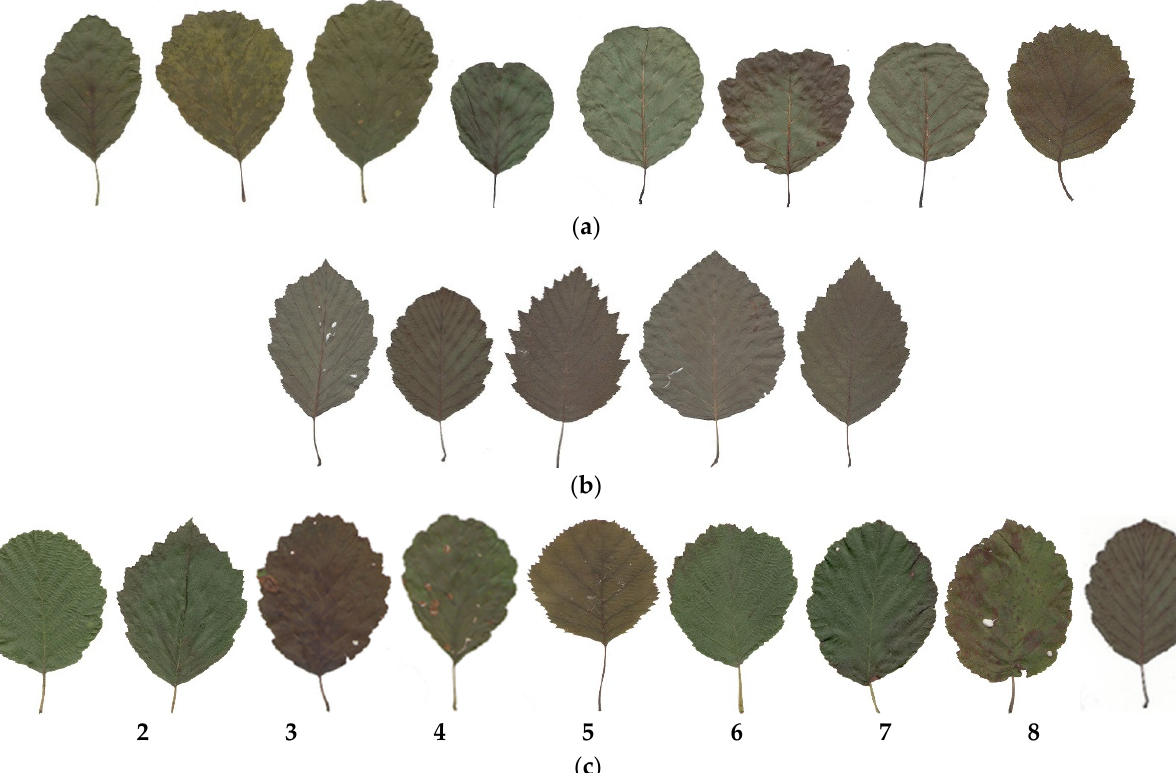
Figure 7. Variation of leaf forms of the parental species Alnus glutinosa ( a ), A. incana ( b ), and their hybrids ( c ). The leaves numbered 1, 6, 7, 8, and 9 in the c row are of the F1 hybrids, the leaves numbered 2 and 9 are of the hybrids that have backcrosses with A. incana, and the leaves numbered 3 and 4 are of the hybrids that have backcrosses with A. glutinosa; all have nine pairs of veins, less pubescence, and a blade maximum width greater than A. incana.